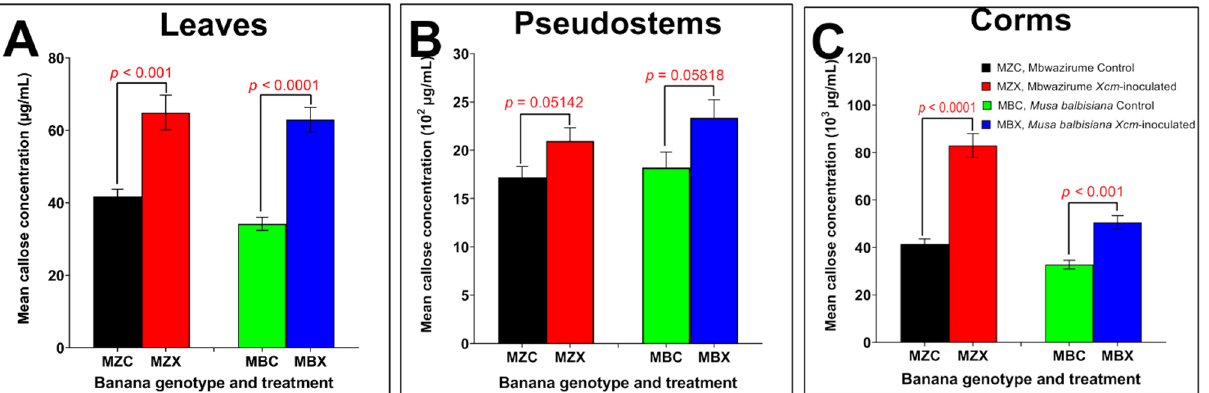
Figure 3. Mean callose concentration in the leaves ( A ), pseudostems ( B ) and corms ( C ) of Xcm -inoculated and control plantlets of Musa balbisiana and Mbwazirume (independent sample t -test, α ≤ 0.05). MZC = Mbwazirume control; MZX = Mbwazirume Xcm -inoculated; MBC = Musa balbisiana control; MBX = Musa balbisiana Xcm